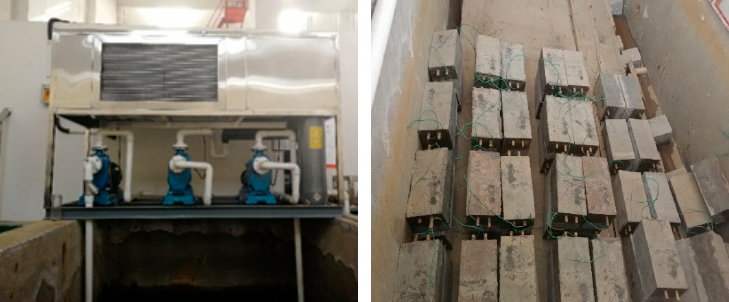
Figure 9. Drying-Wetting Cycles test.